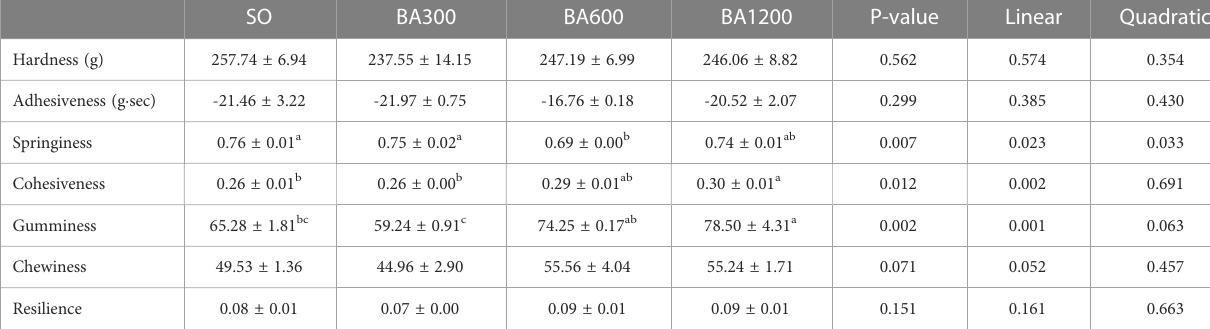
TABLE 6 Dorsal muscle texture of juvenile large yellow croaker in different treatments (Means ± SEM, n = 3) 1 . SO